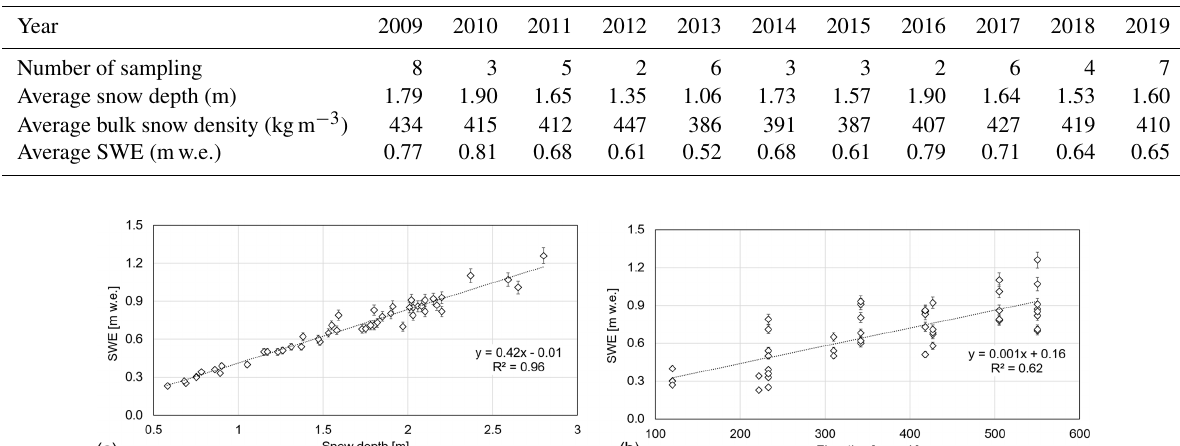
Table 3. Average snow depth and bulk snow density based on data from sampling points (snow pits and drilling cores) on Werenskioldbreen for the years 2009–2019.